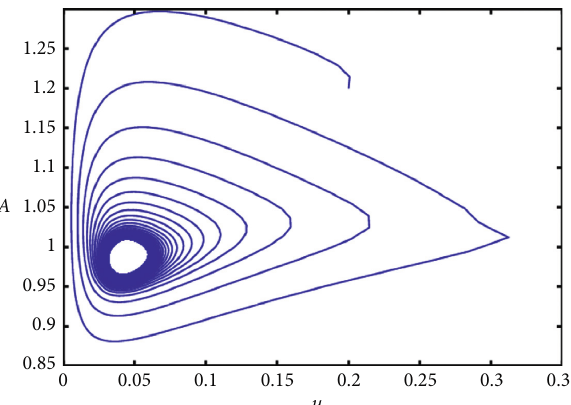
Figure 2: The phase diagram of u − A of system (4) with a � 40, c � 6, λ � 6, r � 0 . 5, b � 1, d m � 0 . 021. It describes the instability of the positive equilibrium and indicates a positive periodic solution exists in the system